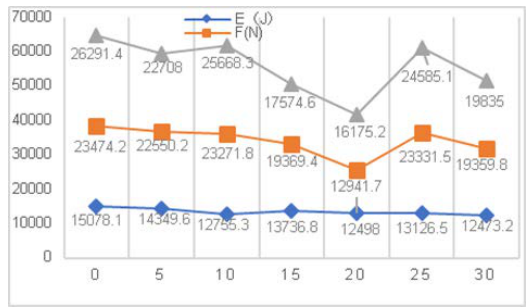
Fig. 13 Data of counter board